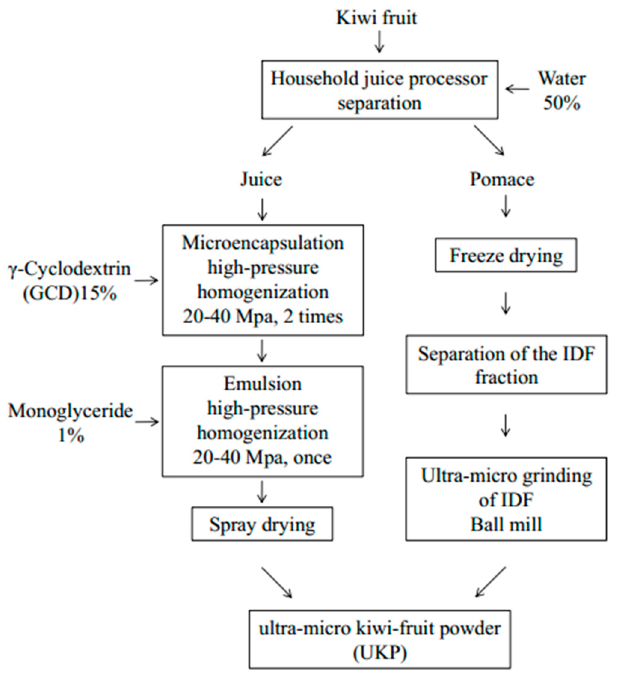
Figure 5. Flow diagram of microencapsulation and grinding process of the ultra-micro kiwifruit powder (UKP) products.